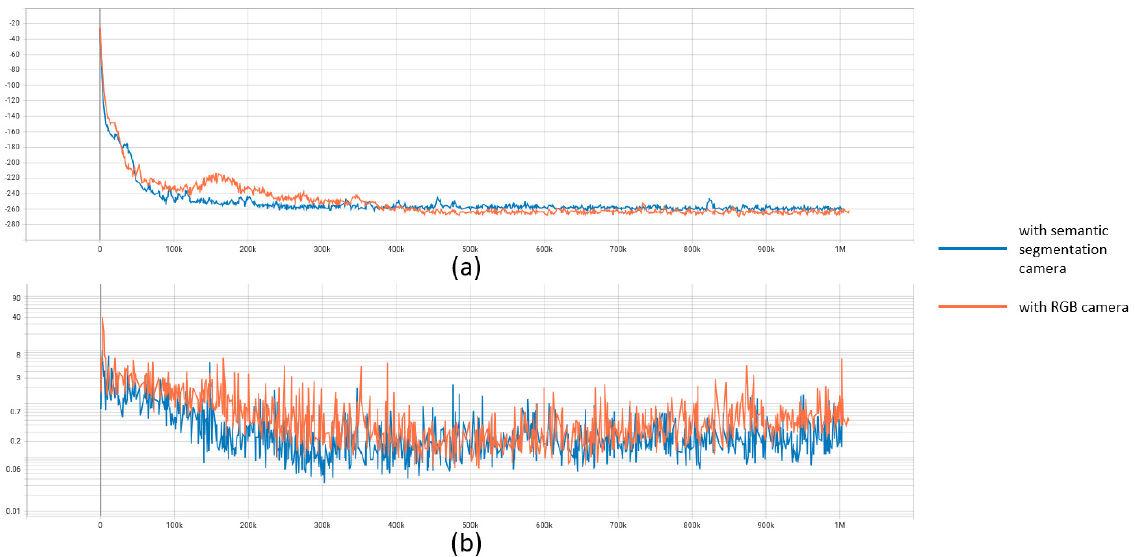
Figure 20. ( a ) The actor loss of RDPG during the training procedure; ( b ) The critic loss of RDPG during the training